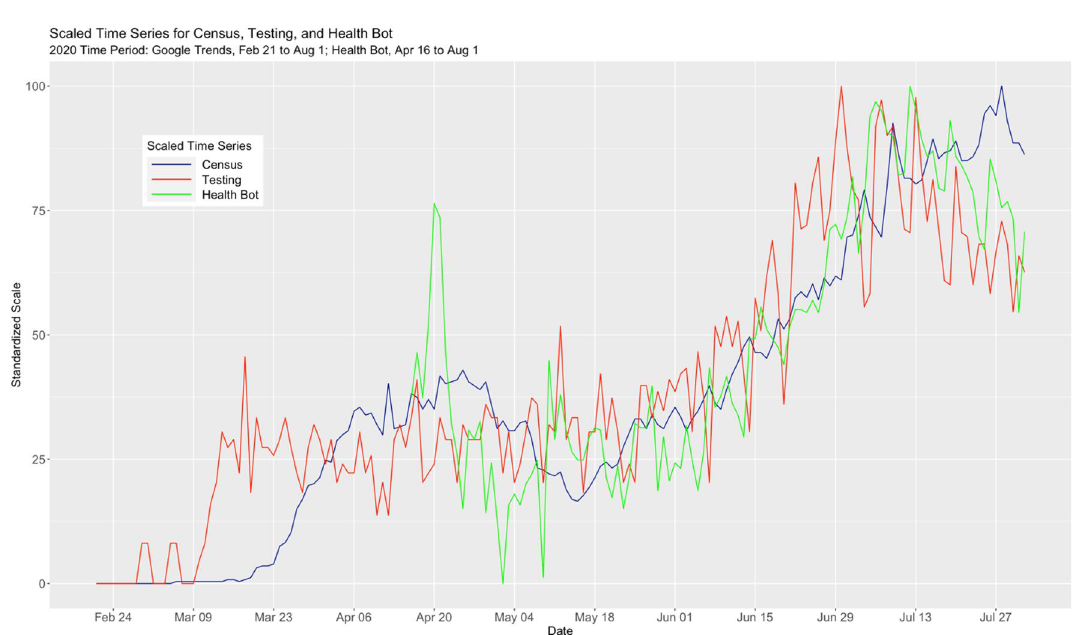
Figure 3. Multivariate time series plot for census and the two internet variables health bot and